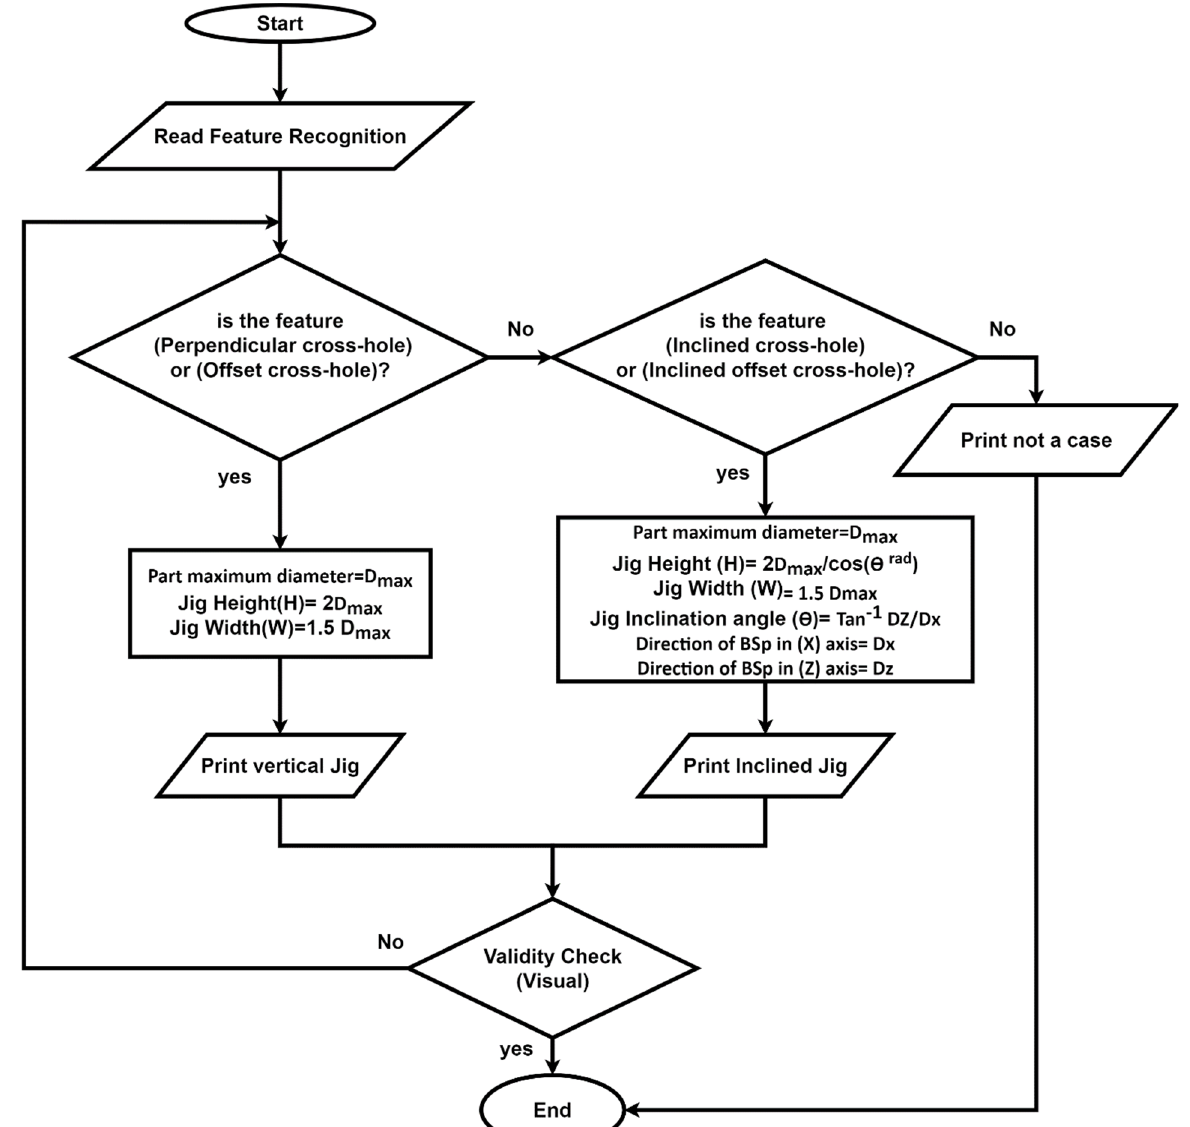
Figure 5. Flowchart of computer-aided traditional jigs and fixtures design.